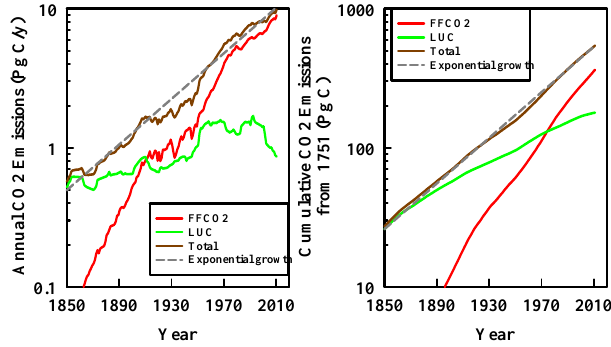
Fig. 3h. Annual and cumulative global CO 2 emissions for years 1850 to 2007. Left panel: Annual global CO 2 emissions from fossil fuels and other industrial processes including cement manufacture (FFCO2, red), land use change (LUC, green) and total (FFCO2 + LUC, brown). Right panel: Cumulative global CO 2 emissions from 1751, color coded as in left panel. Axes are linear-log so that exponentially growing emissions appear as a straight line. In both panels, the FFCO2 is the same global fuel use data as displayed in Fig. 1b. In both panels, the dashed grey line is a fit to the total (FFCO2 + LUC) emissions data of an exponential-growth model with a growth rate of 1.9% per year. This corresponds to a doubling of emissions and cumulative emissions every 37 years. The unit of petagrams carbon (Pg C) is equal to 10 15 grams of carbon.